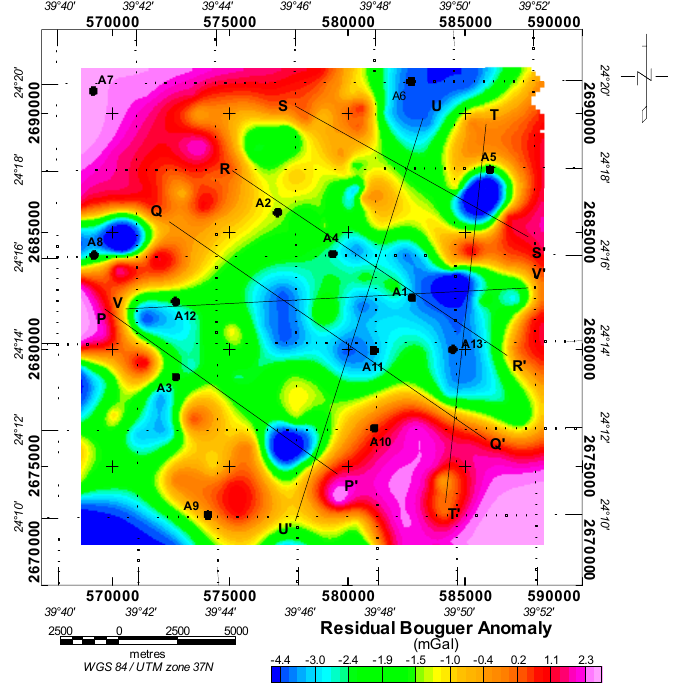
Figure 5. The residual Bouguer anomaly map of the study region. A unique negative gravity anomaly feature can be identified in the central region of the map, with negative gravity anomalies in the northeast (A5 and A6). Similar anomalies can also be observed in the western (A1 and A13) and central (A11) regions. The profiles taken across the identified anomalous region (Profiles PP’, QQ’, RR’, SS’, TT’, UU’, and VV’) are used for the modeling procedures in this study.